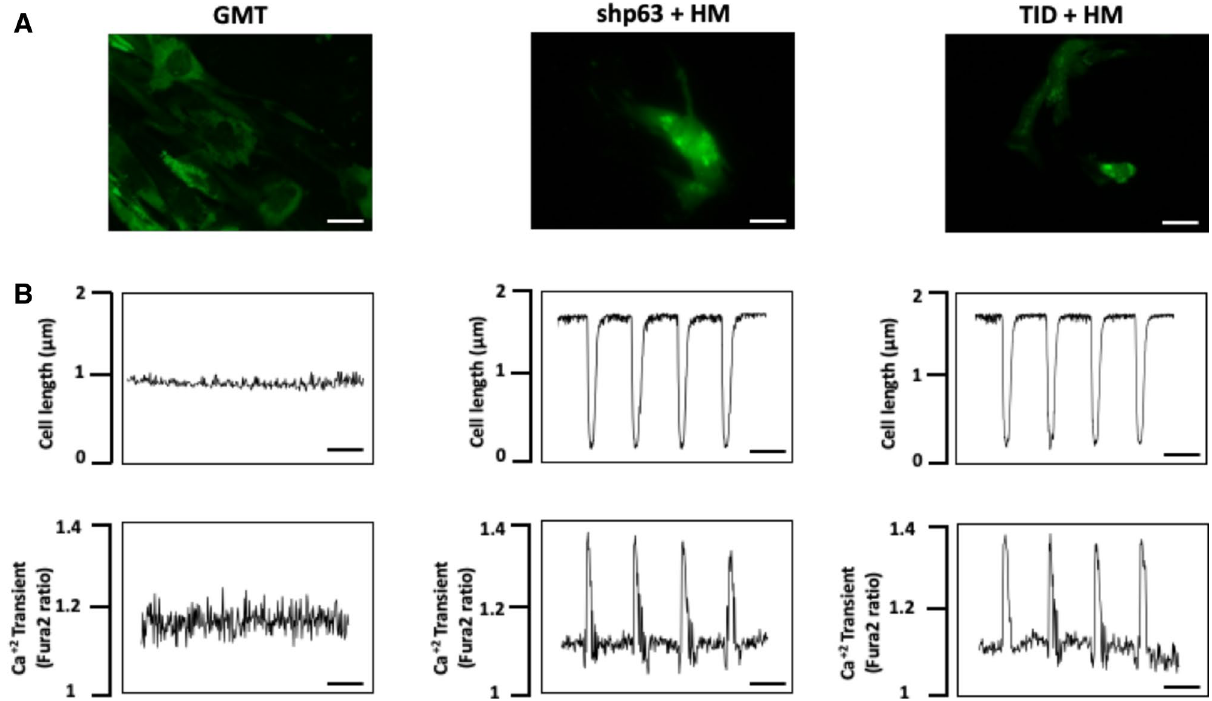
Figure 5. Functional efficacy of human cardiac fibroblast reprograming after co-culture with neonatal rat cardiomyocytes. Adult human cardiac fibroblasts were treated with lentivirus expressing GMT (left), shp63 in combination with Hand2/Myocardin (middle) or p63-TID+ Hand2/Myocardin (right). One week after initial transduction, these human cardiac fibroblasts were co-cultured with (untreated) neonatal rat cardiomyocytes (negative for GFP [green fluorescent protein]). ( A ) Representative immunofluorescence demonstrating (green) GFP expression by human cardiac fibroblasts treated with GMT (left), shp63+ H/M (middle) or p63-TID+ H/M (right) after 4 weeks in co-culture with (non-transduced) neonatal rat cardiomyocytes. Bar = 100 μm. ( B ) Representative peaks from GFP + human cardiac fibroblasts treated with GMT, shp63+ H/M and p63-TID+ H/M after 4 weeks of co-culture, reflecting contraction (top row) and Ca 2+ transients (bottom row). Contractility parameters were not observed in cells treated with GMT alone. Bar = 1